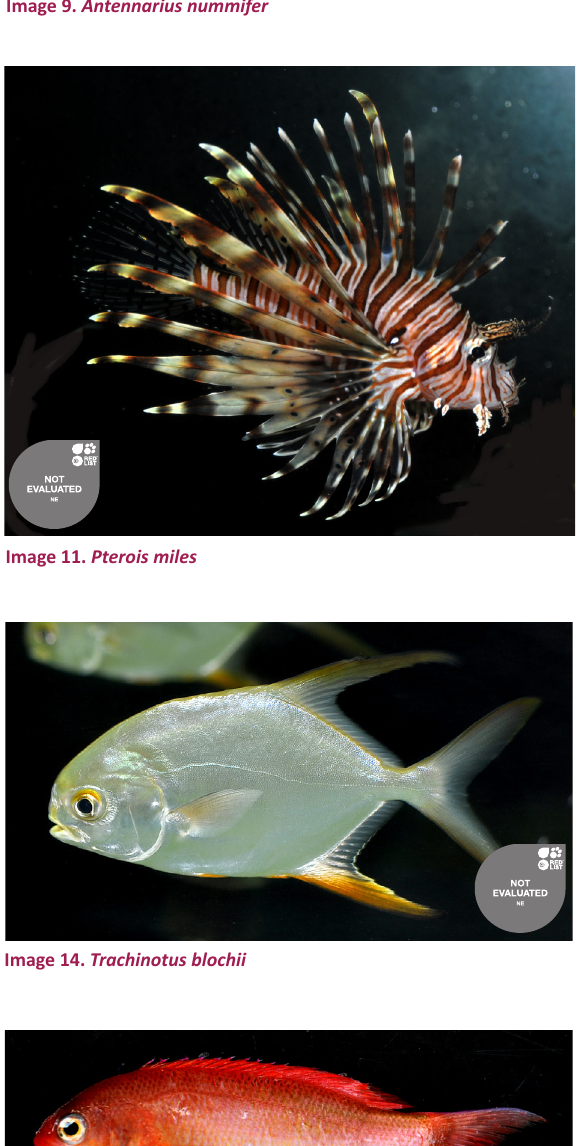
Image 16. Lutjanus